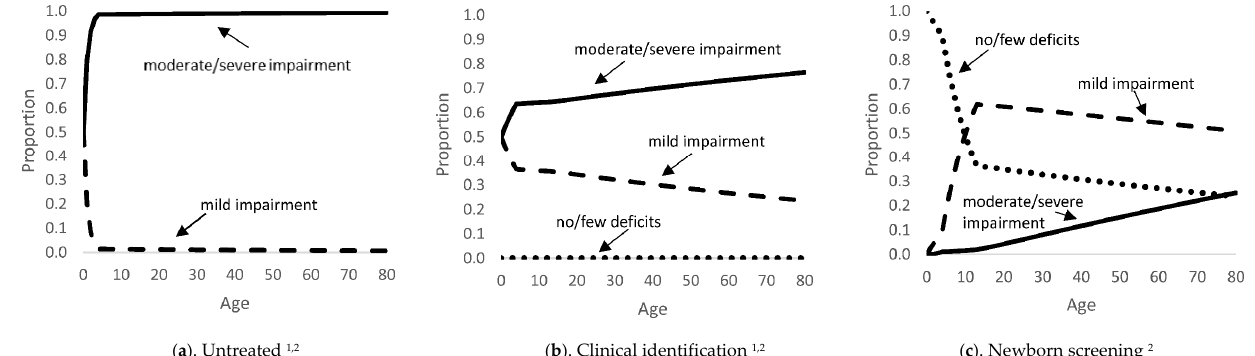
Figure 2. Proportion of Hypothetical Cohort of PKU Patients by Health State and Age–diet treatment only (no medication), partial adherence. 1 Individuals with PKU that are untreated or identified through clinical identification start with mild or moderate/severe impairment. 2 These figures only reflect the proportion of individuals alive at that age and does not include those that have died.